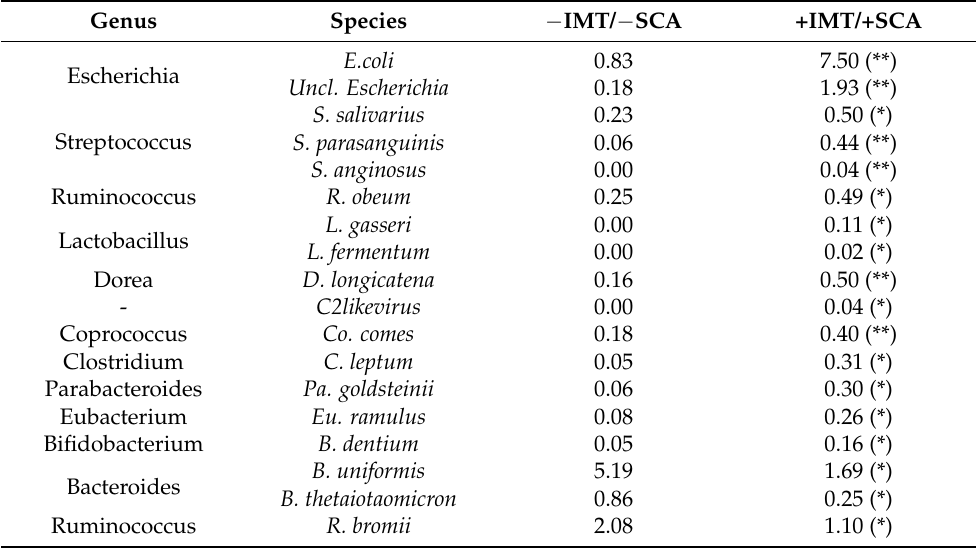
Table 2. Reduced and increased abundances of genera and species in +IMT/ + SCA. Genus Species − IMT/ −